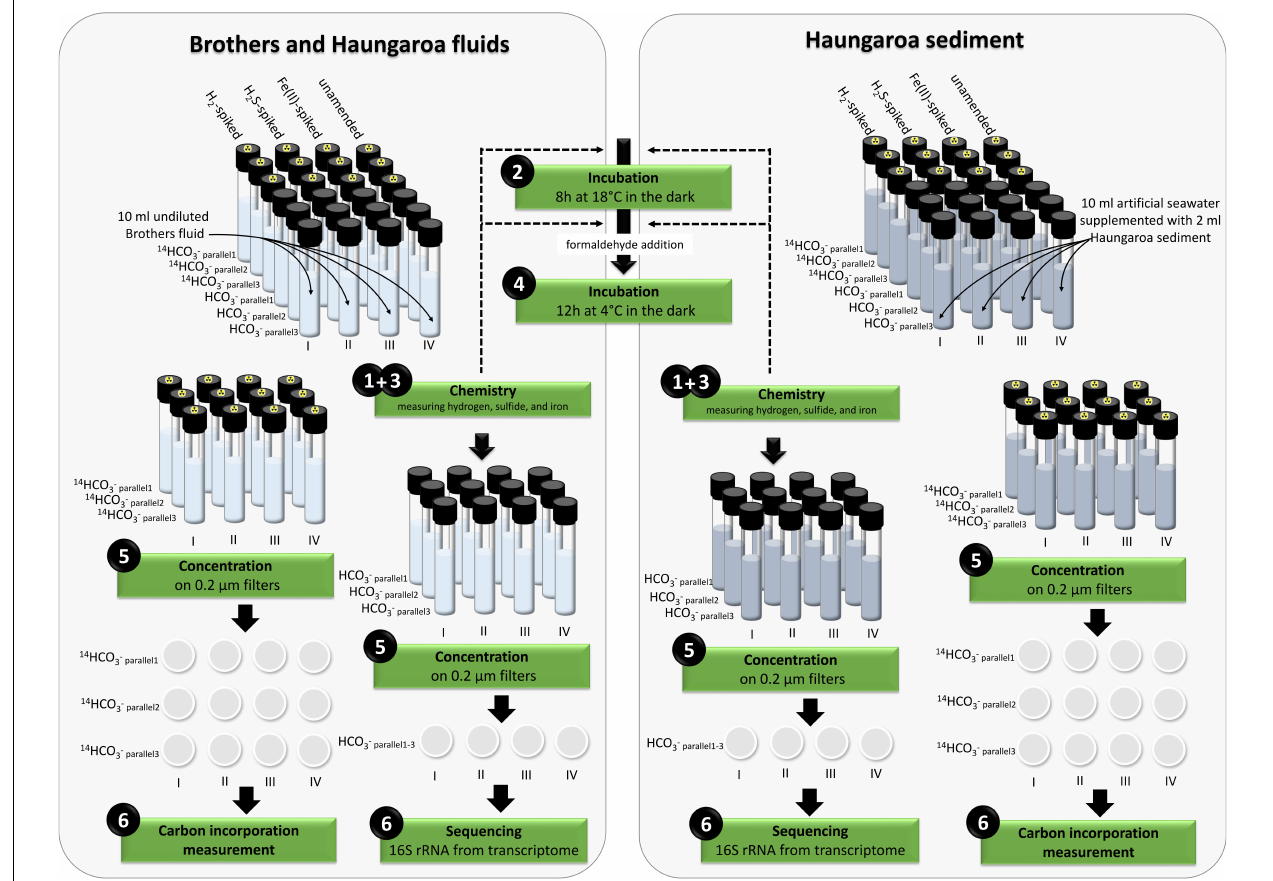
FIGURE 1 | Overview of the set-up of the incubation